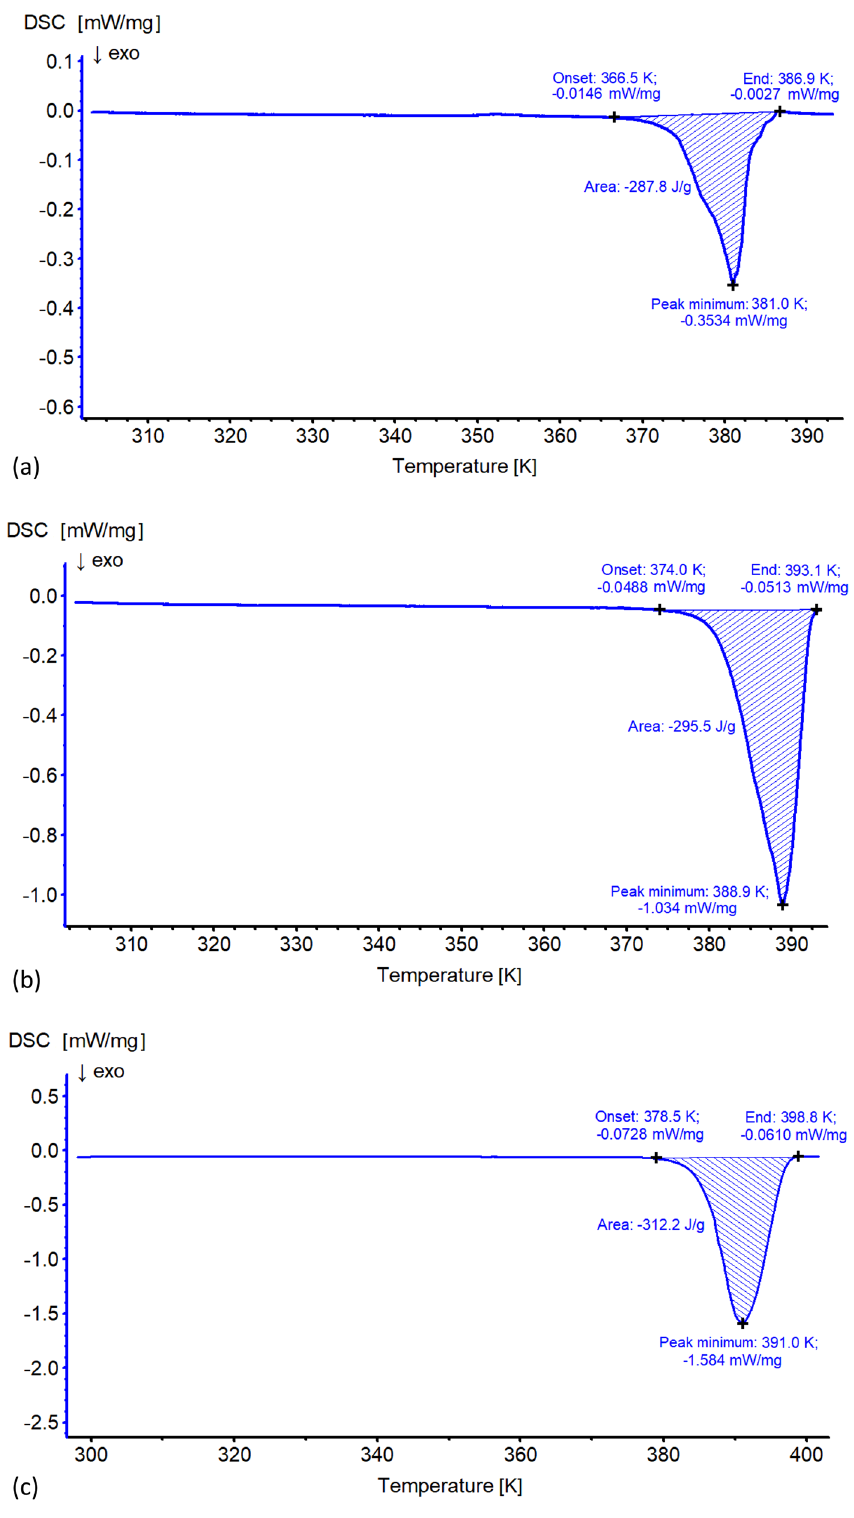
Figure 8. The DSC curves for struvite for different heating rates: ( a ) 0.4 K/min, ( b ) 1.2 K/min, ( c ) 2.0